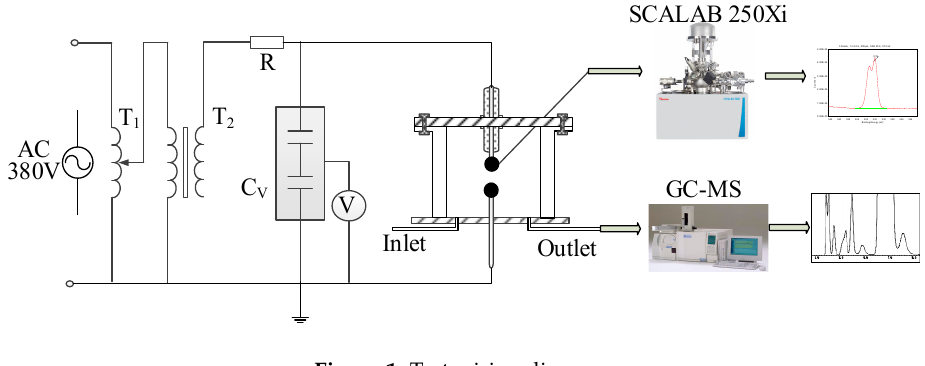
Figure 1. Test wiring diagram.